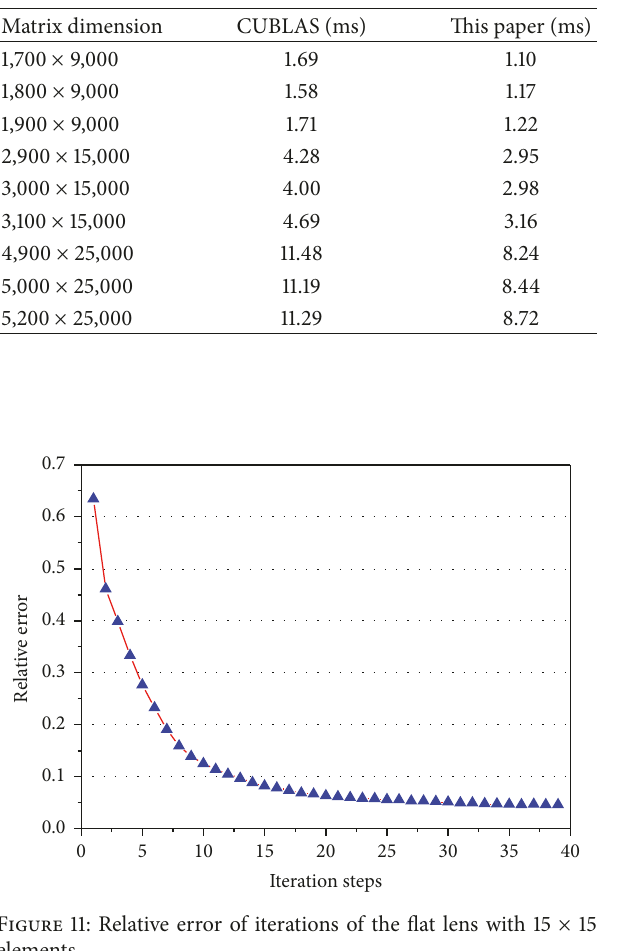
Table 5: Comparison in MVP for nonsquare matrix.